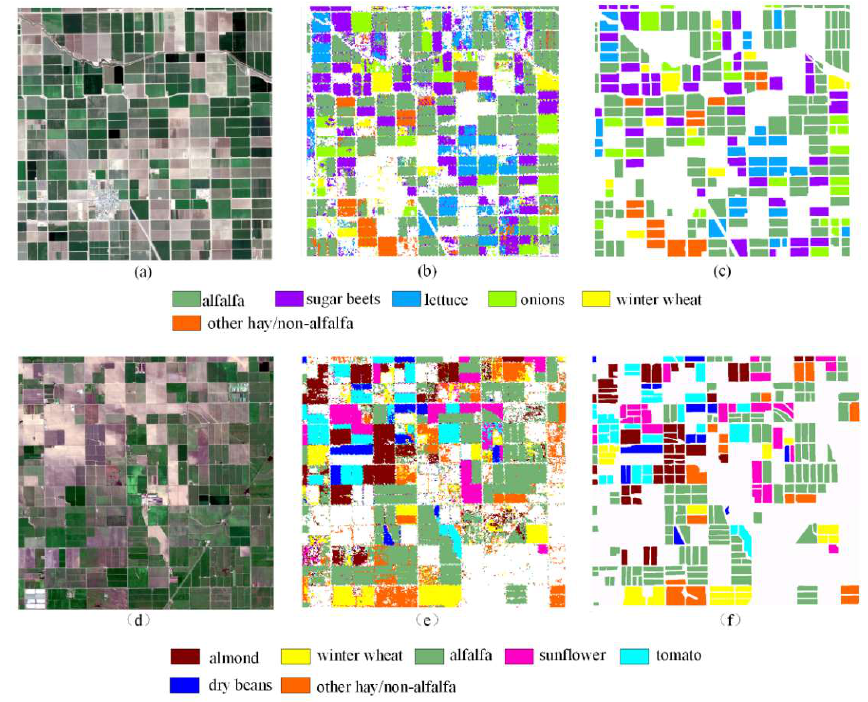
Figure 3. Ground truth maps of the study area. ( a ) RGB image of study area 1 from Sentinel-2 on 2018 / 03 / 12, ( d ) RGB image of study area 2 from Sentinel-2 on 2019 / 02 / 10. ( b , e ) the CDL data (major crop types) for 2018 and 2019, respectively. ( c , f ) manually labeled ground reference data.